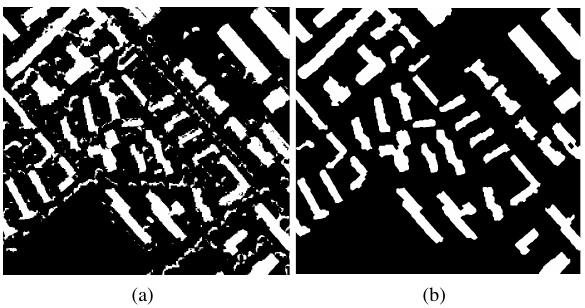
Figure 7: The original mask (a) and the refined (b) masked using the proposed